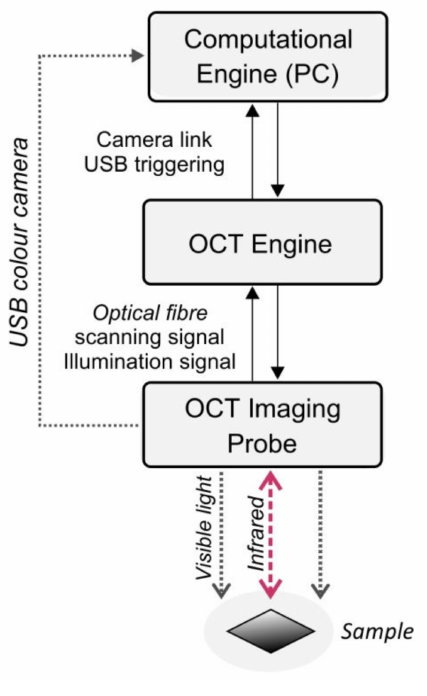
Figure 5. Optical coherent tomography (OCT) setup. Table 2. Characteristics of Cordura OCT